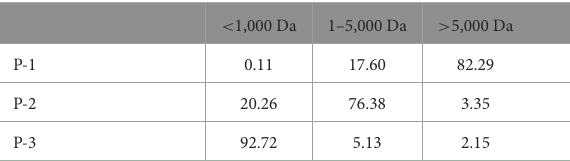
TABLE 1 Molecular weight distribution of CSP (%).